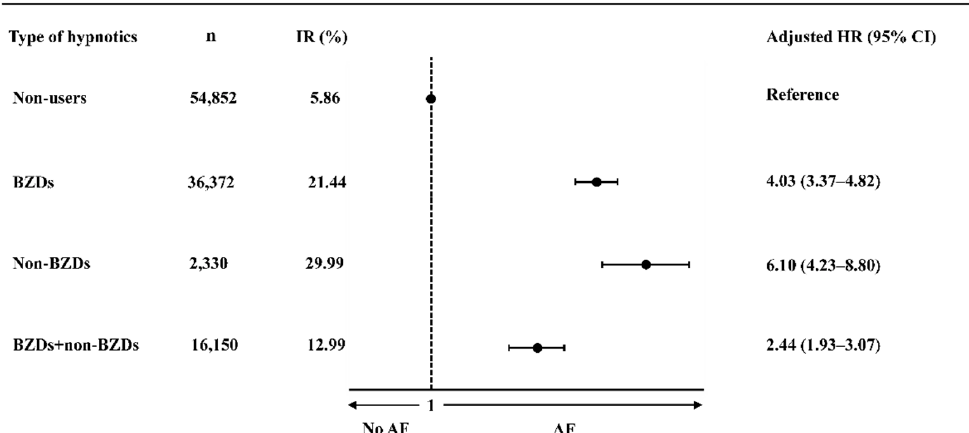
Figure 2. The subsequent risk for atrial fibrillation associated with use of either or both of benzodi- azepines and non-benzodiazepines. Hazard ratios (HR) for the incident atrial fibrillation (AF) compar- ing the users with either or both of benzodiazepines (BZDs) and non-BZDs with non-hypnotics users were estimated by the Cox proportional model with multiple adjustments for socio-demographic fac- tors, clinical comorbidities, and concomitant medications at baseline. The multivariate-adjusted HRs for the prescribed use of BZDs alone, non-BZDs alone, or their combinations without priorities were represented by black diamonds, and their confidence intervals (CIs) were represented by error bars.